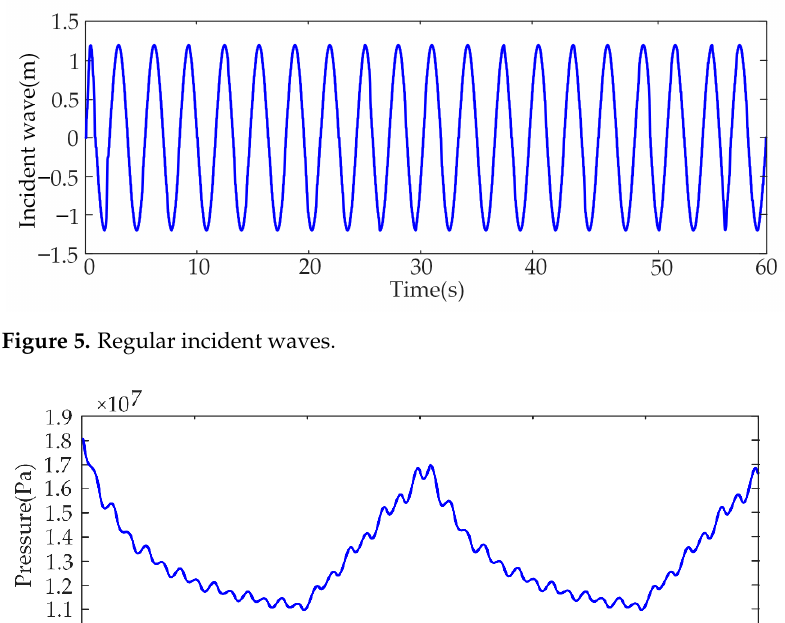
Figure 5. Regular incident waves.